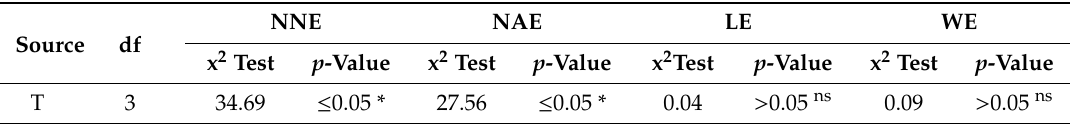
Table 1. Analysis of deviance for the effect of different maturation temperatures in the number of normal (NNE) and abnormal somatic embryos (NAE) per 0.08 g of embryonal masses; the length (LE-mm) and width of normal embryos (WE-mm) of Pinus radiata D.Don.